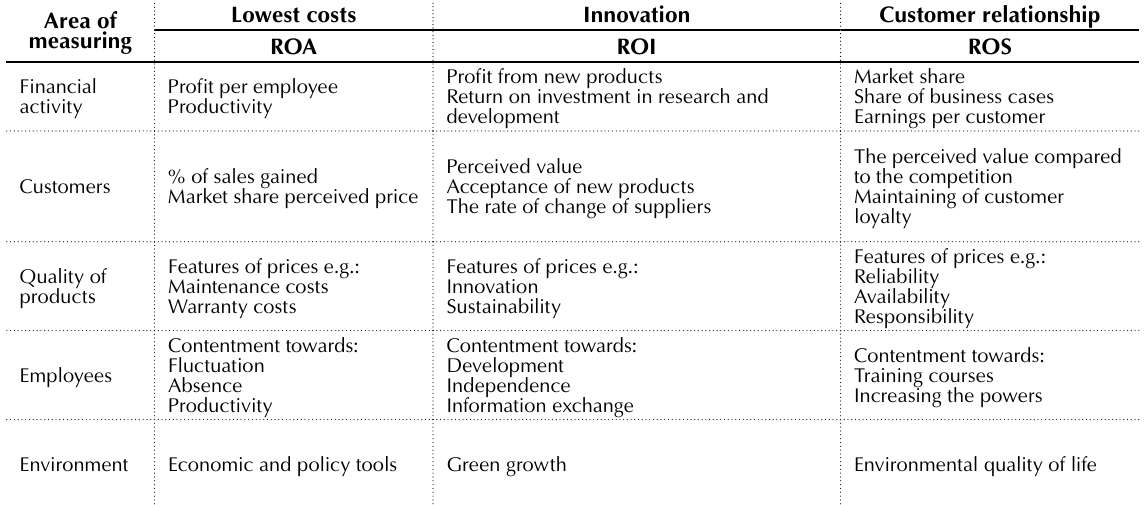
Source: Horváth and Partners (2002).